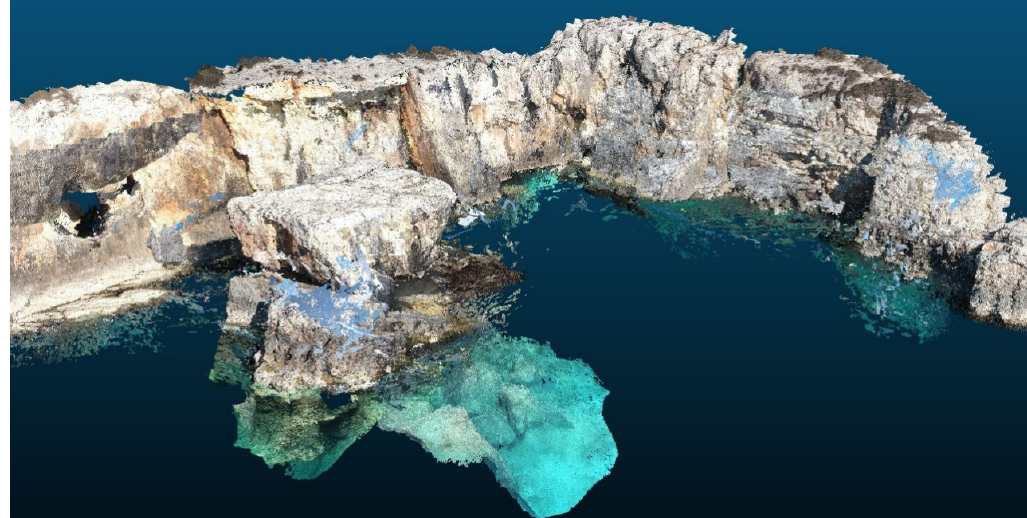
Figure 14. Dense cloud of the emergent and submerged part of the plunging cliffs at Premantura using both horizontal images and tilted drone images.